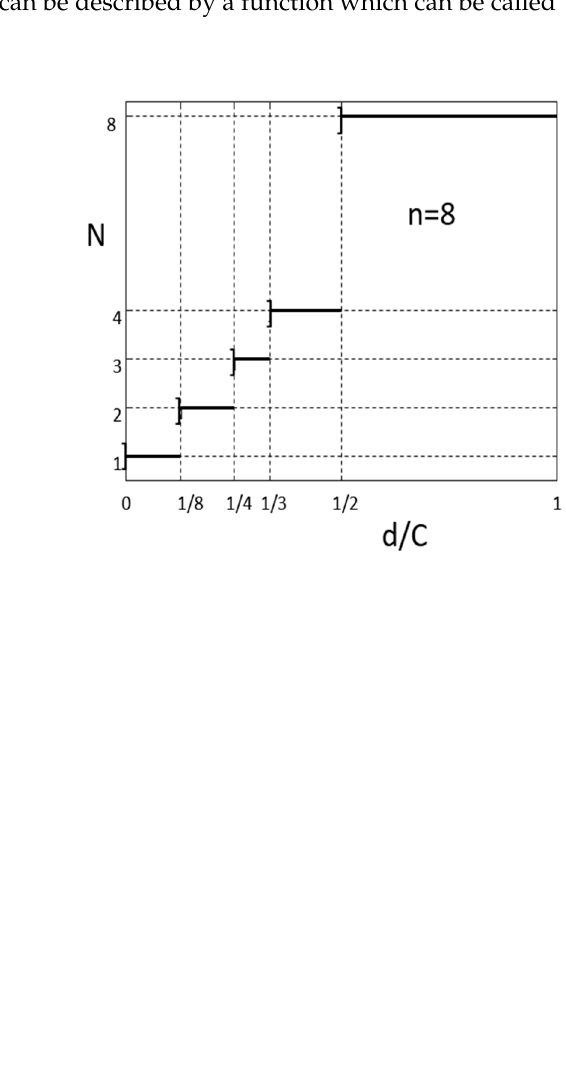
Figure 2. The variation of optimum number N of drones as function of vaccination centre demands, for n = 7, 8, and 9.